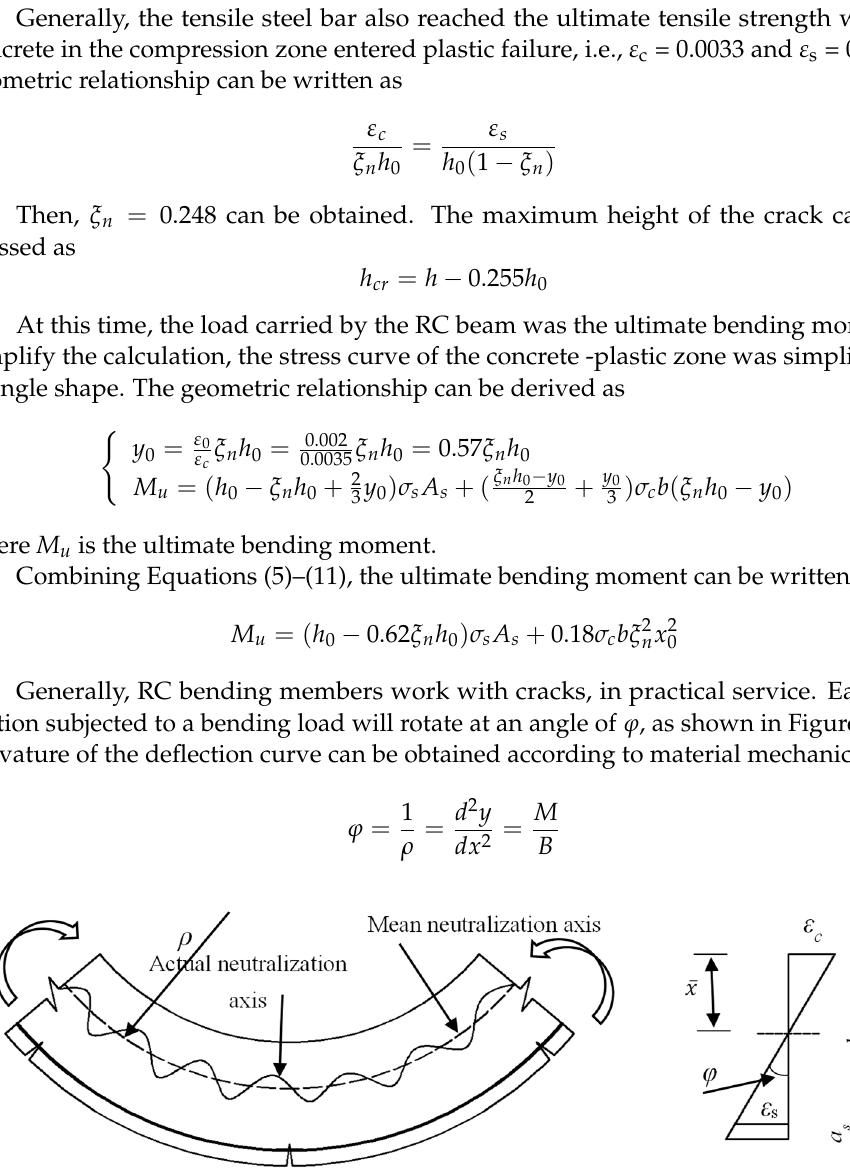
Figure 17. Schematic diagram of the assumed plane section.